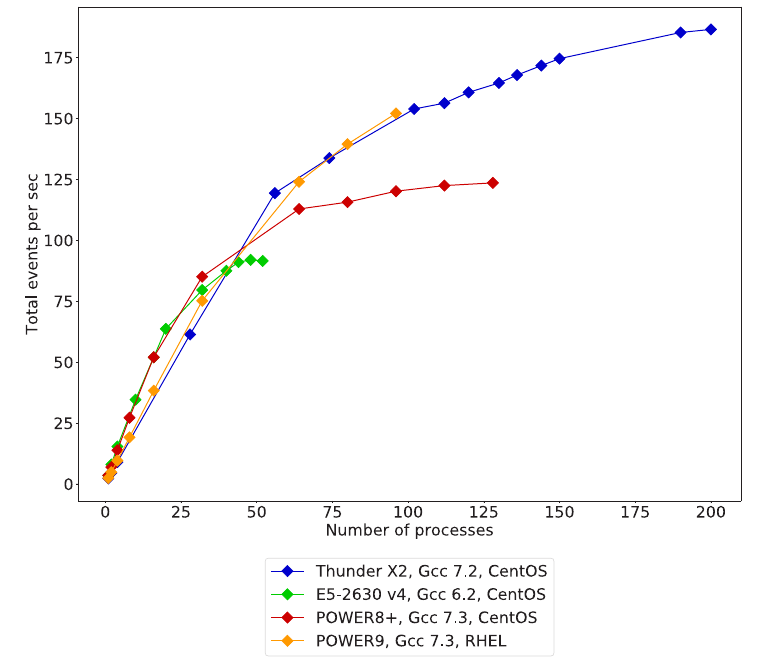
Figure 1: Performance based on average time of one event per